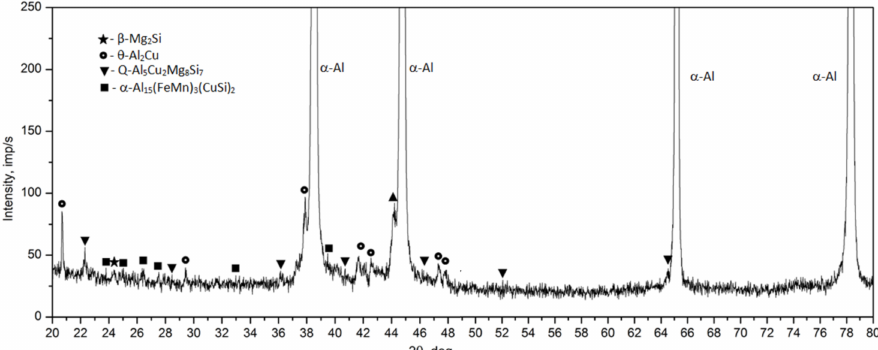
Figure 15. Diffraction pattern of the 2017A alloy solution heat treated from 510 ◦ C and aged naturally for 200